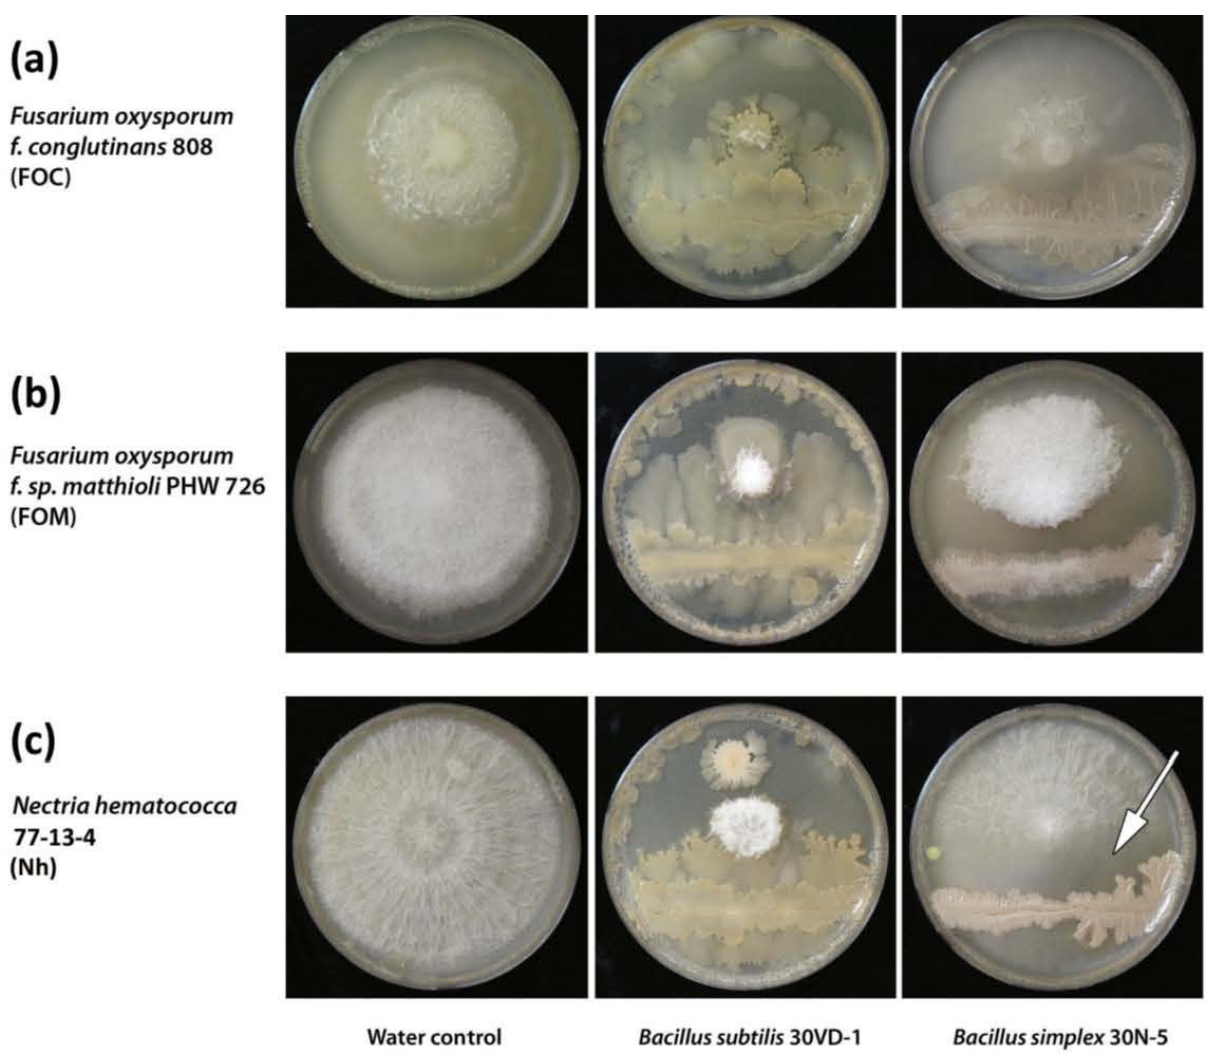
Figure 7. Effect of Bacillus strains on fungal growth. Responses of FOC (a) and FOM (b) to water (negative control), B. subtilis 30VD-1, and B. simplex 30N-5 following 13 days of culture on filtered V8 agar. B. subtilis 30VD-1 has almost completely surrounded the fungal culture. B. simplex limits the growth of both FOC and FOM, but not as much as the 30VD-1 strain does (middle column); (c) Response of Nectria haematococca 77-13-4 to the negative control and to the Bacillus strains on filtered V8 agar. An increase in transparency of the fungus is observed on the side closest to the B. simplex 30N-5 streak (arrow), whereas for the uninoculated control, the appearance of the fungal colony is the same throughout. B. subtilis 30VD-1 has almost completely surrounded the